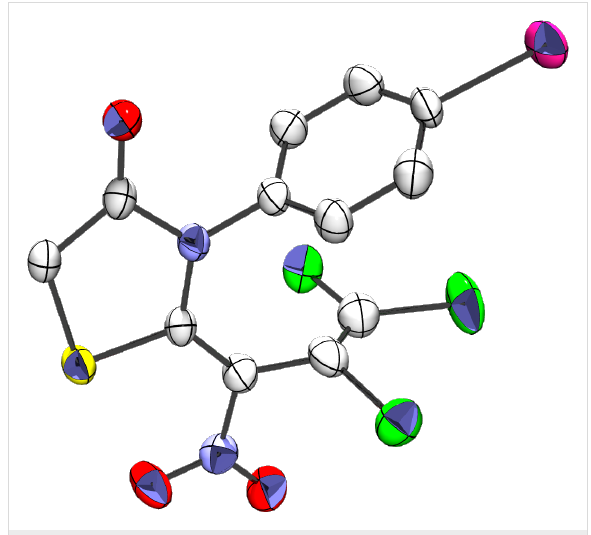
Figure 2: X-ray analysis of thiazolidin-4-one 11 . The formation of the thiazolidin-4-ones 7 – 18 is assumed to consist of three individual steps. In a S N Vin type reaction with the aniline derivative intermediate A (Scheme 3) is formed. Subsequently, the thus introduced amino group attacks the car- bonyl carbon of the mercaptoacetate moiety. This ring closure affords the temporary imide hemiacetal B which is then stabi- lized upon elimination of the corresponding alcohol to give the desired thiazolidin-4-ones 7 – 18 (Scheme